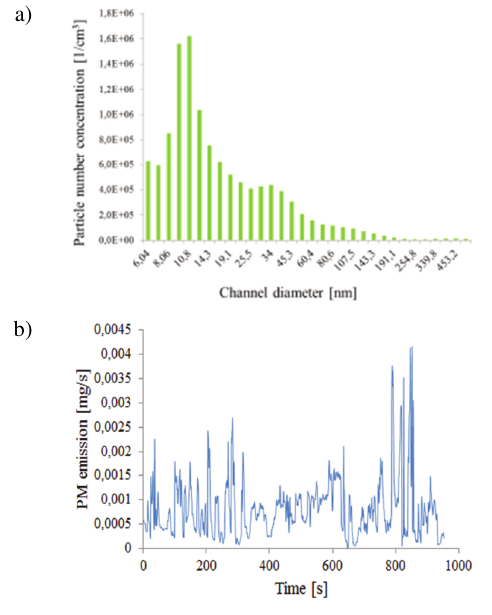
Fig. 8. Solid components of exhaust gases: a) particle number concentra- tion, b) particle mass The emission of nitrogen oxides reached a value similar to that determined in the Euro 6b homologation standard was the smallest relative to the other parts of the RDE test. Table 4. Specific distance emissions results during an extra-urban cycle Specific distance emission during an extra- urban